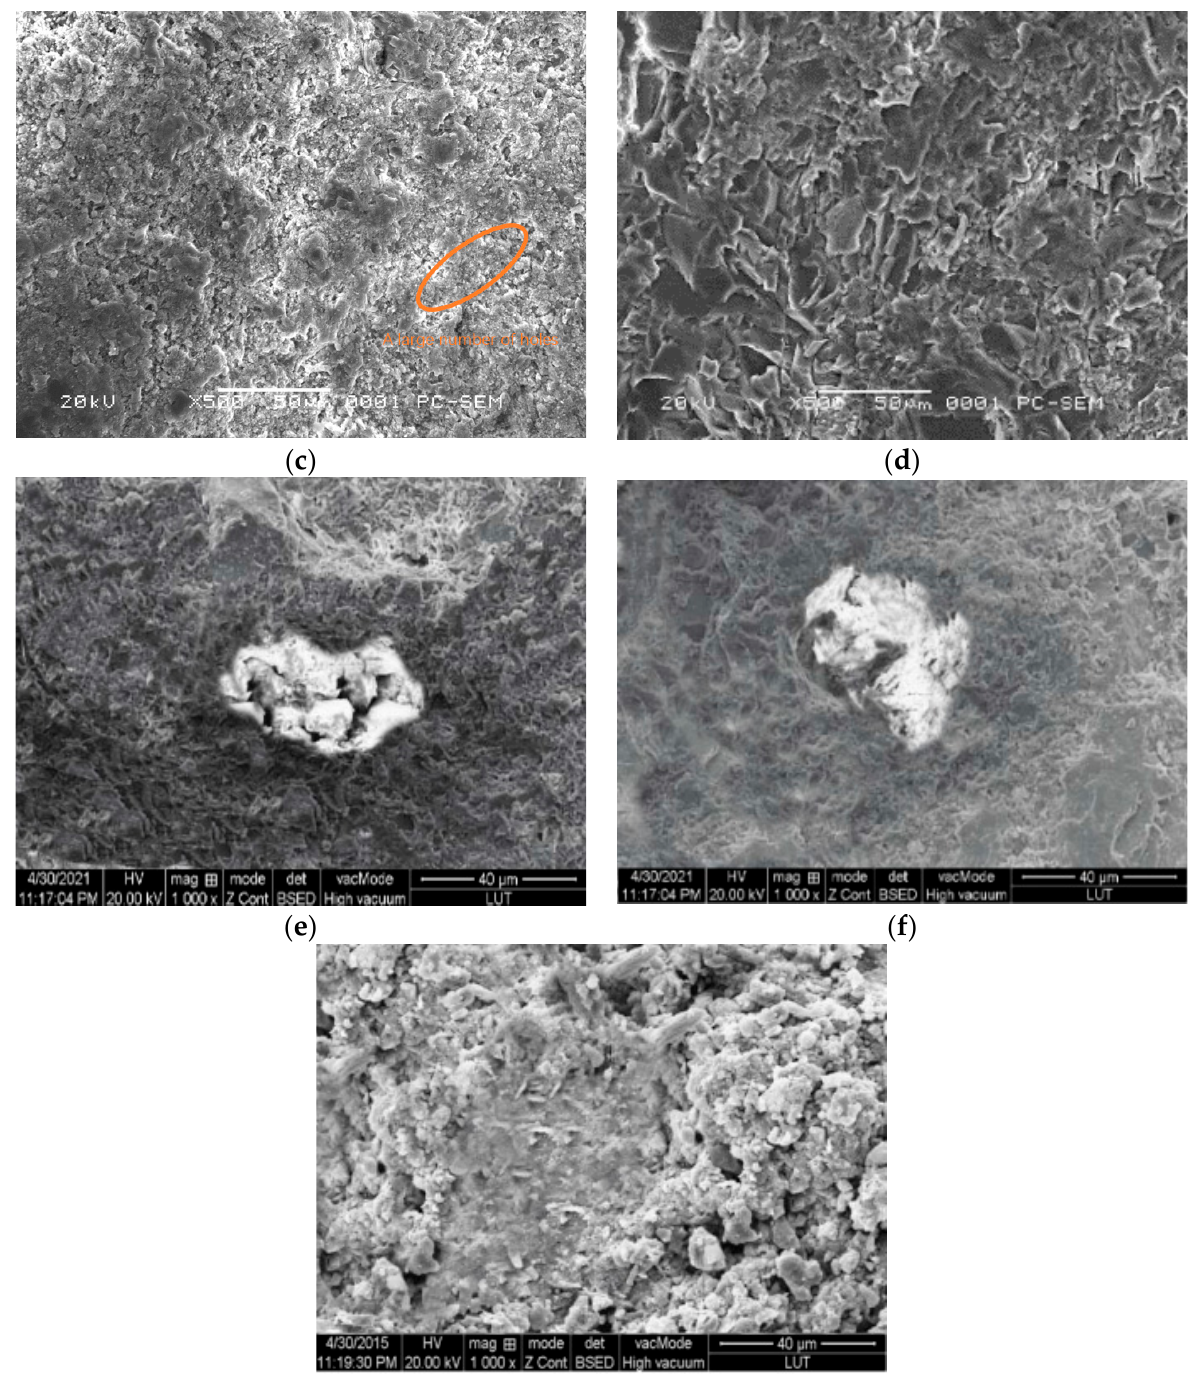
Figure 9. SEM photographs of rock after 60 F–T cycles for three treatments: ( a ) untreated samples (500×); ( b ) snowmelt (500×); ( c ) rain infiltration (500×); ( d ) normal F–T (500×); ( e ) corrosion of feldspar (1000×); ( f ) corrosion of calcite (1000×); and ( g ) increase in clay (1000×).